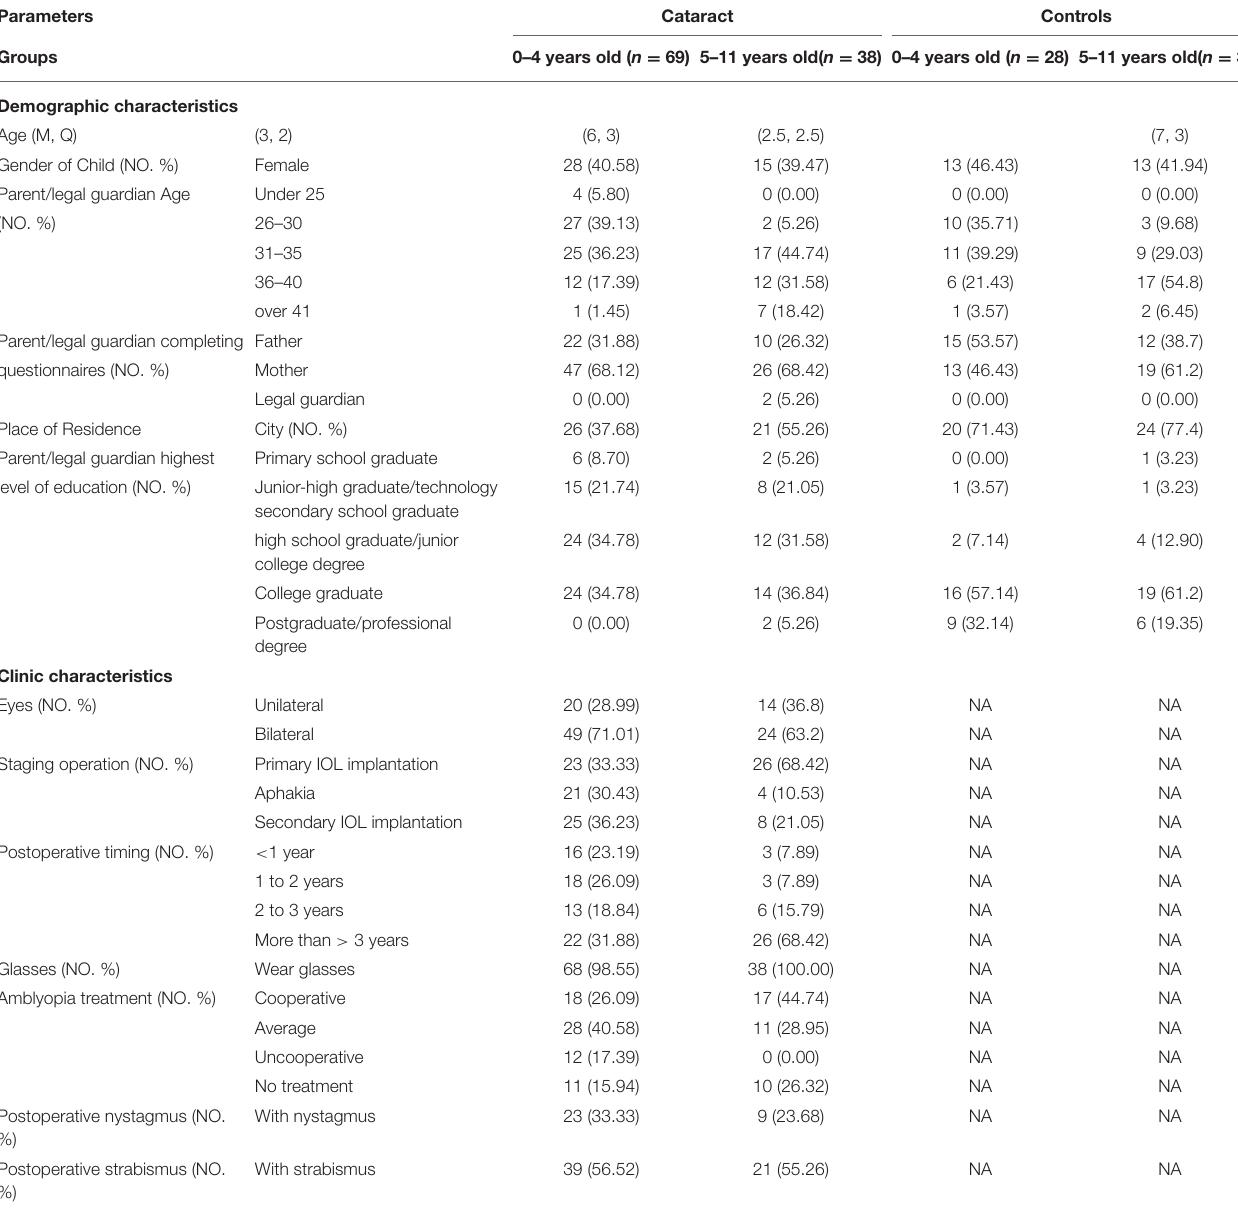
TABLE 1 | Demographics and clinic characteristics of children in different ages completing the Pediatric Eye Questionnaire and their parents. Parameters Cataract Controls